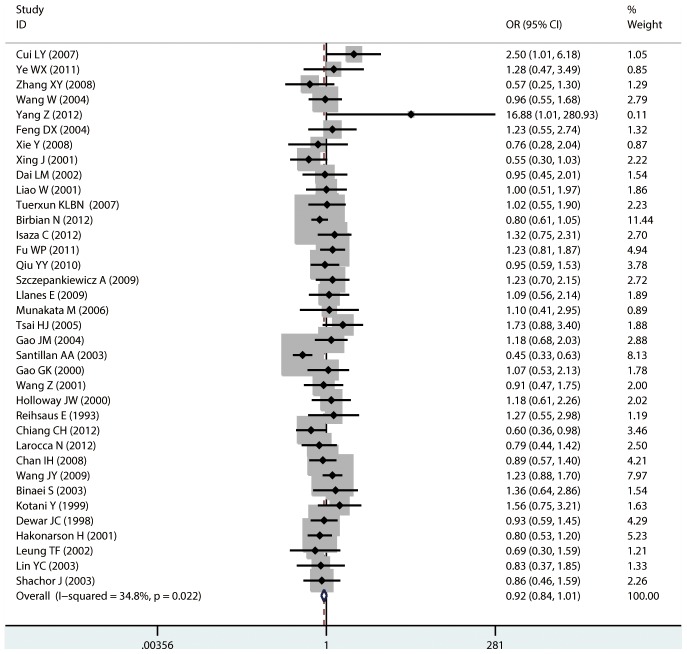
Forest plots of the association between the Gln27Glu (rs1042714) polymorphism and risk of asthma in dominant model comparison.